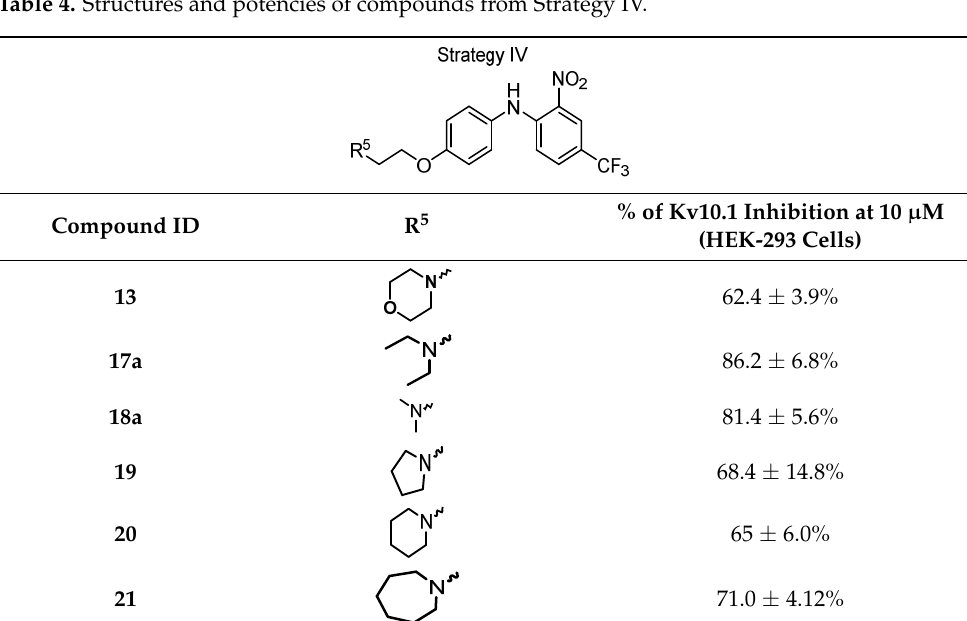
Table 5. Structures and potencies of compounds from Strategy V.